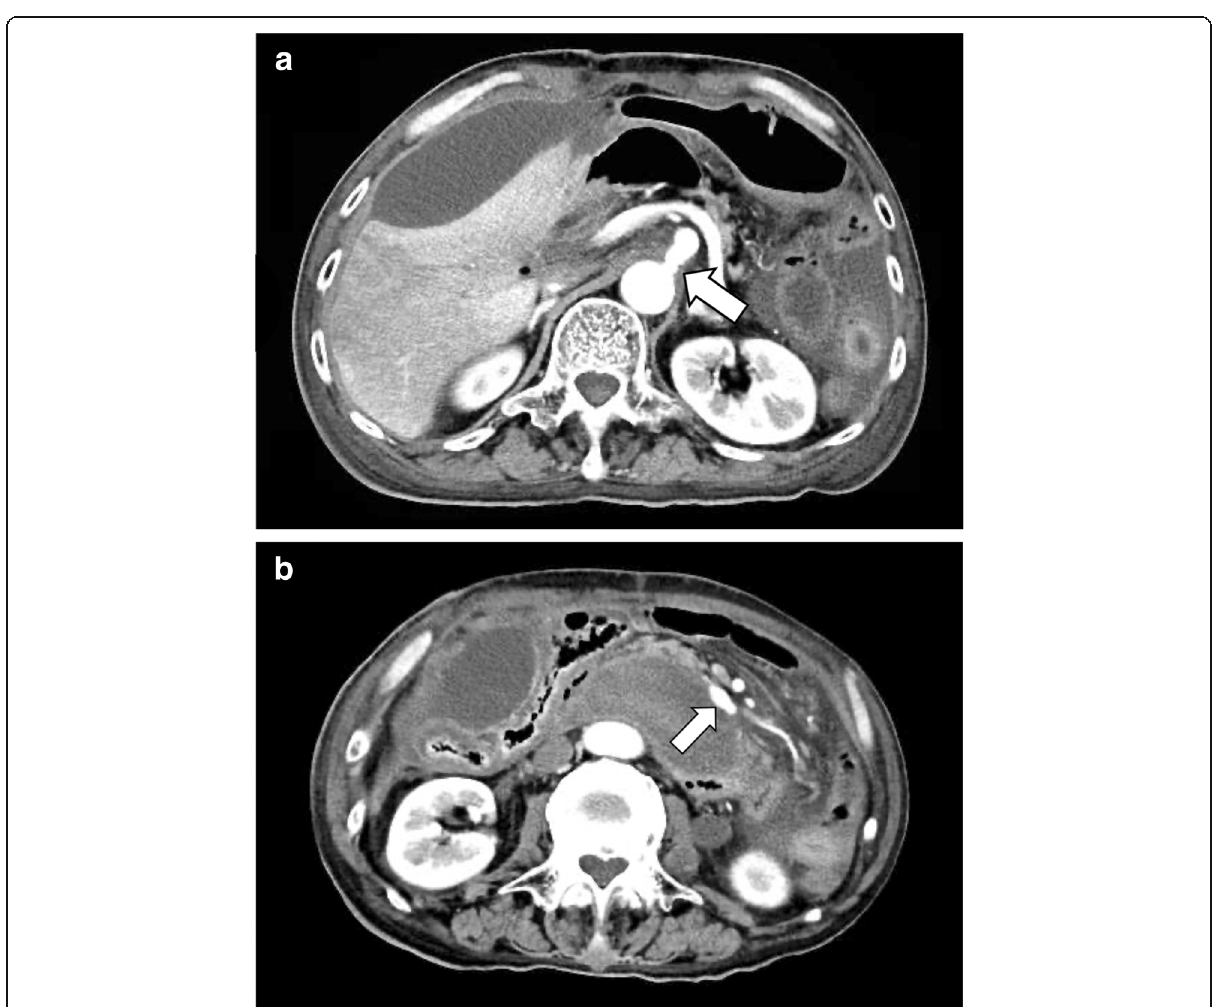
Fig. 6 a The abdominal computed tomography on postoperative day 4 determined that the arterial diameter of the celiac axis has expanded slightly (shown by arrow). b The abdominal computed tomography on postoperative day 4 determined that there was no significant change in the size (13 × 7 mm) of the untreated aneurysm of the anterior inferior pancreaticoduodenal artery (shown by